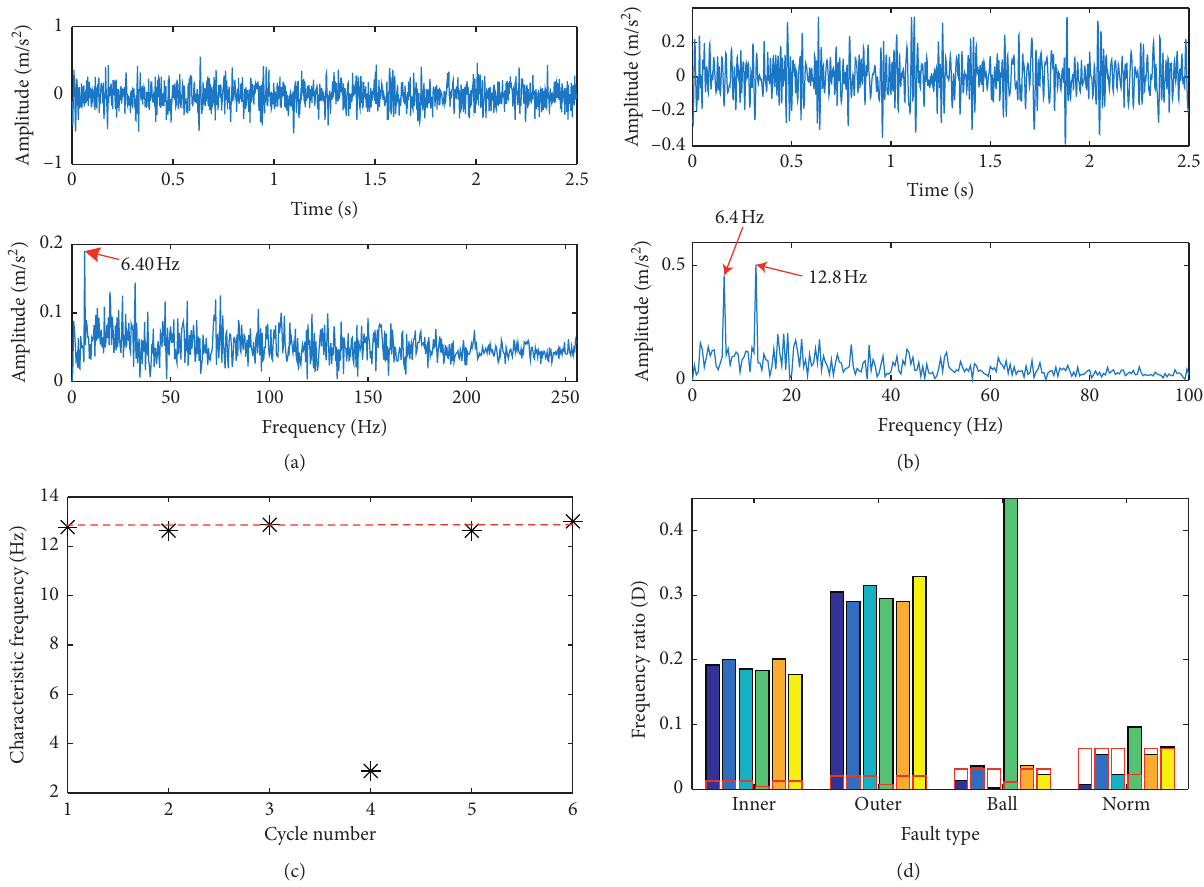
Figure 16: The diagnosis process of bearing rolling element fault: (a) the original signal; (b) the reconstructed signal; (c) characteristic frequency in each cycle; (d) the frequency ratio of fault types in each